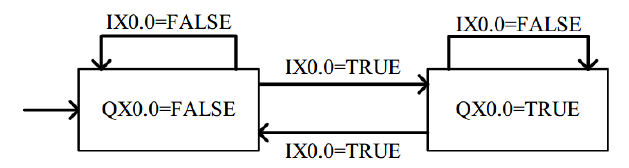
Figure 4. The State Graph of the Toggle.